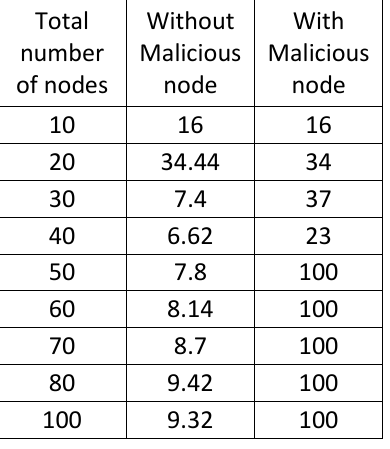
Table 24:- Packet loss ratio